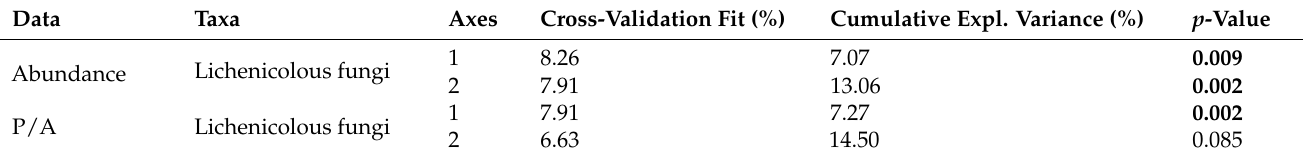
Table 3. Cross-validatory fit and cumulative explained variance of the predictive Co-CA axes for lichenicolous fungi (lichens are used as a predictor variable) reported both for presence/absence and abundance data. Significant p -values resulting from permutation tests are marked in bold.